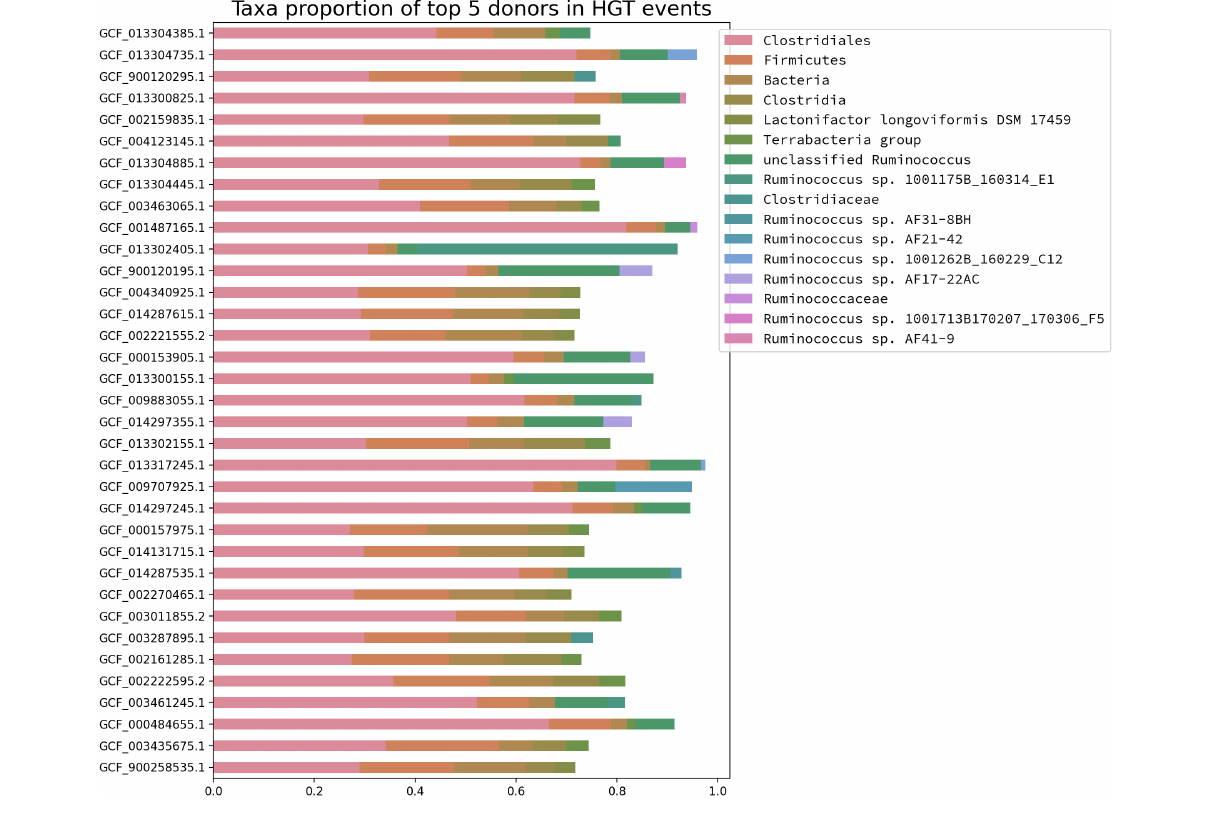
FIGURE 5 | Taxonomic abundance profile of the top five HGT donors for the Blautia genomes from the representative dataset. Each genome was analyzed by HGTector and the frequency of taxonomic assignments for the top 5 putative donors were plotted for each case. The color code corresponds to the donors listed in the legend (upper right